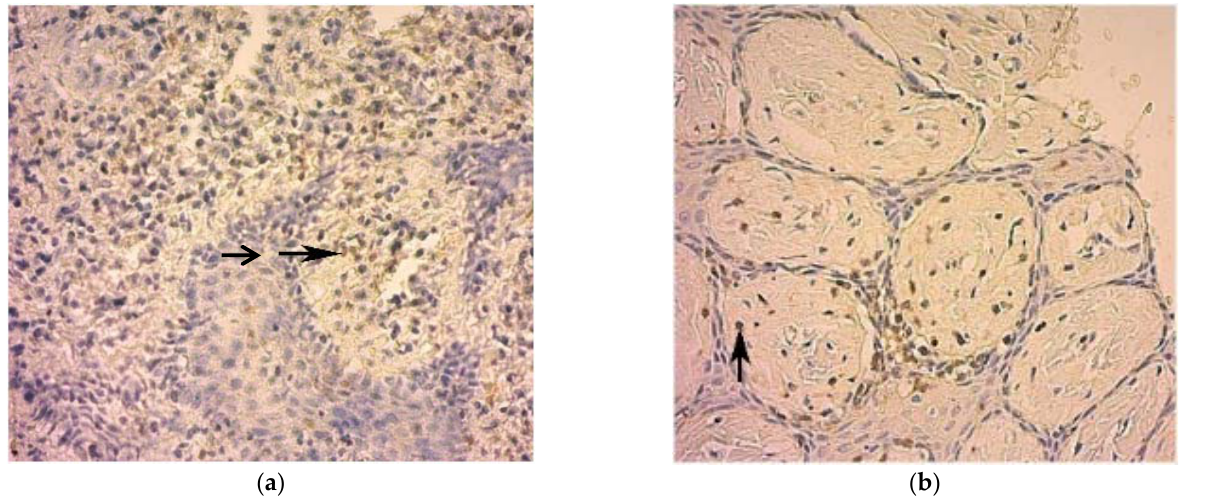
Figure 3. ( a , b ). Diffuse positive reaction to CD3+ in the cells of the inflammatory infiltrate (horizon- tal arrow) in the oral mucosa in patients with HCV ( × 100) ( a ). Focal positive reaction to CD20+ in scattered single cells of the inflammatory infiltrate (vertical arrow) of the oral mucosa in the patient with HCV ( × 400) ( b )